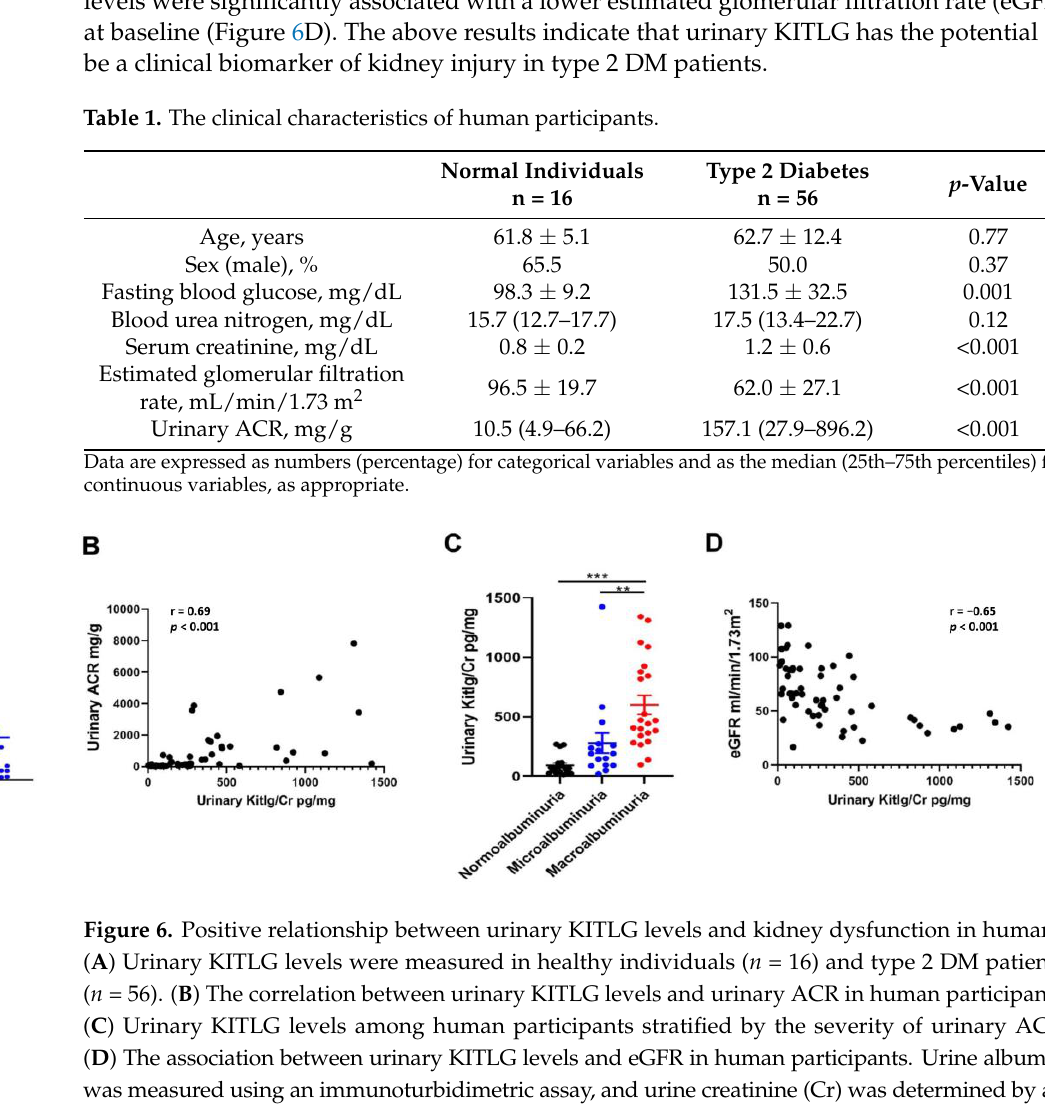
Table 1. The clinical characteristics of human participants.